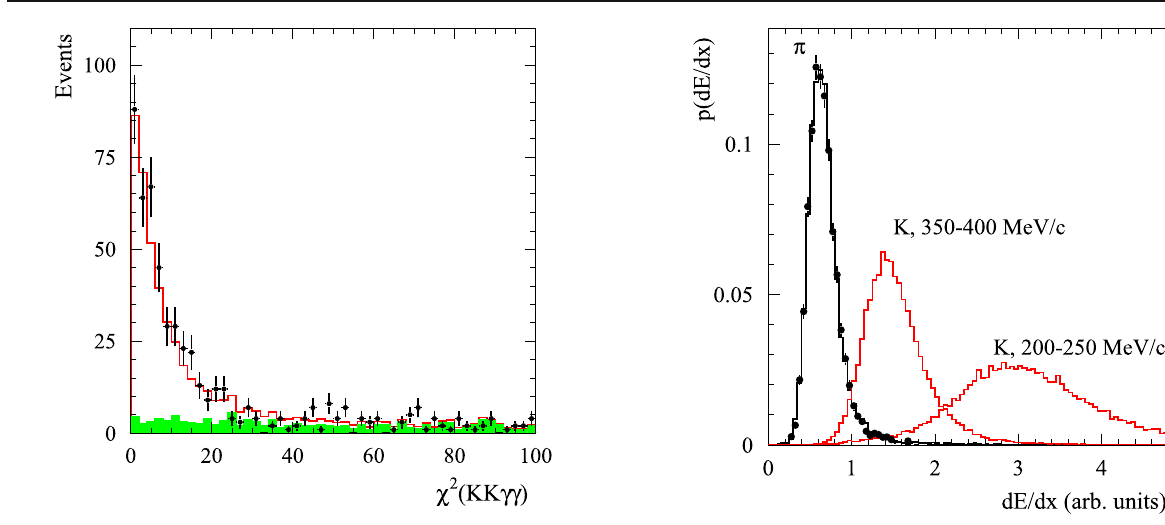
Fig. 1 The χ 2 ( K K 2 γ) distributionfordataeventswith100 ≤ m γγ ≤ √ Fig. 2 The probability density distribution of the ionization losses in s < 1 . 72 GeV (points with error 170 MeV/ c 2 from the interval 1 . 5 < the drift chamber for pions and kaons. The points with error bars repre- bars).Thesolidhistogramisthesumofthesimulatedsignaldistribution sent the data distribution for pions from e + e − → π + π − π 0 π 0 events, and the background distribution. The hatched histogram represents the the histogram is the same simulated distribution. The kaon distributions background for two momentum ranges are obtained using e + e − → K + K − π 0 sim-